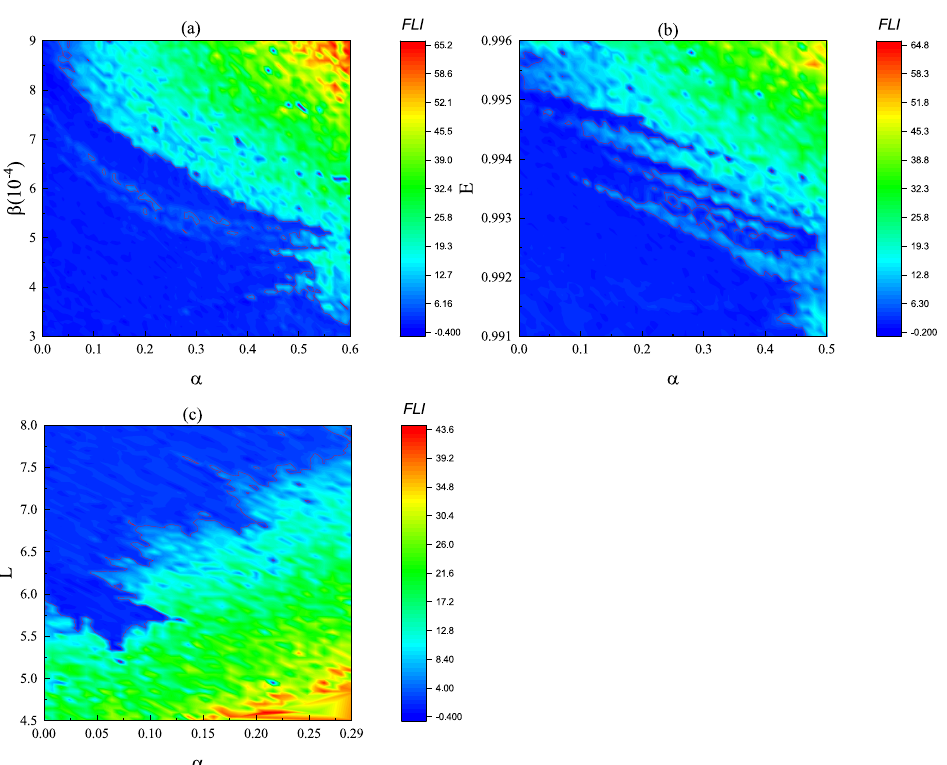
Figure 4. Distributions of two parameters corresponding to order and chaos in terms of FLIs. The initial radius is r = 110. ( a ) Distributions of α and β . The other parameters are E = 0.995 and L = 6. ( b ) Distributions of α and E . The other parameters are β = 7.8 × 10 − 4 and L = 6. ( c ) Distributions of α and L . The other parameters are β = 7.8 × 10 − 4 and E = 0.995. These figures show that chaos becomes stronger as α , β and E increase or L decreases.